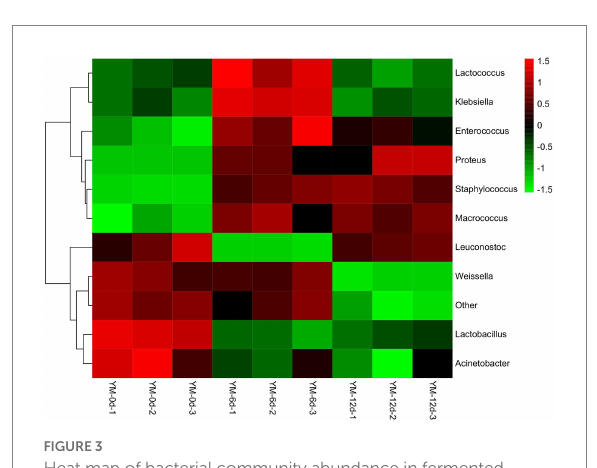
FIGURE 3 Heat map of bacterial community abundance in fermented sausage at genus level during ripening